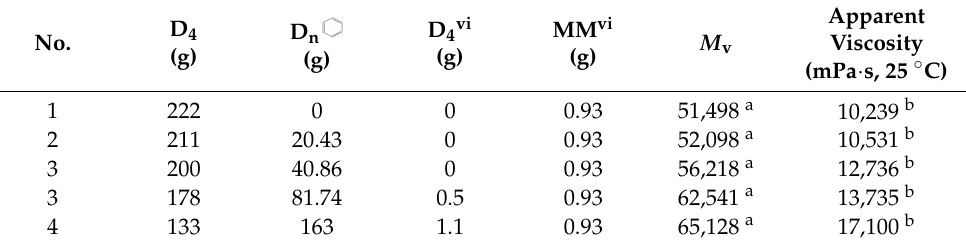
Table 1. Summary of the composition and characterization of silicone oils with different phenyl content.